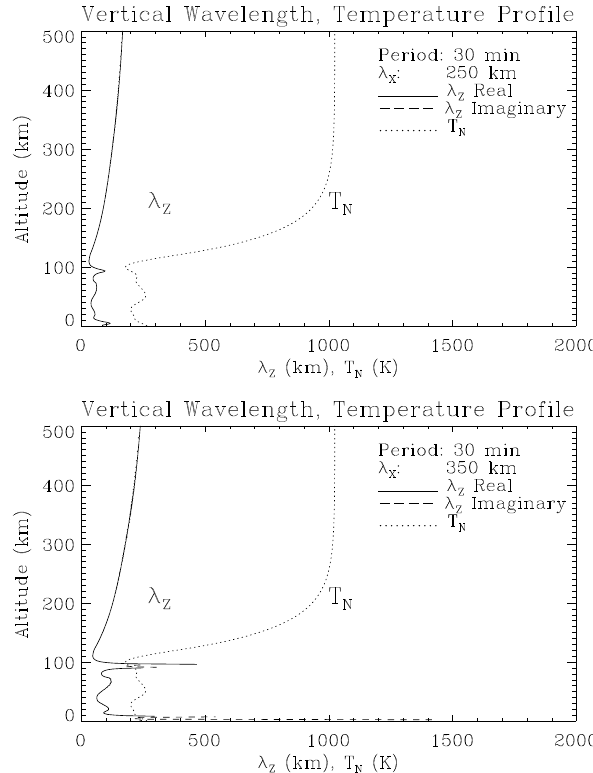
Fig. 3. Altitude profiles of the MSIS90 model atmospheric temper- ature and gravity wave vertical wavelength derived from dispersion Eq. (1) for a wave period of 30min and horizontal wavelengths of 250 and 350km.